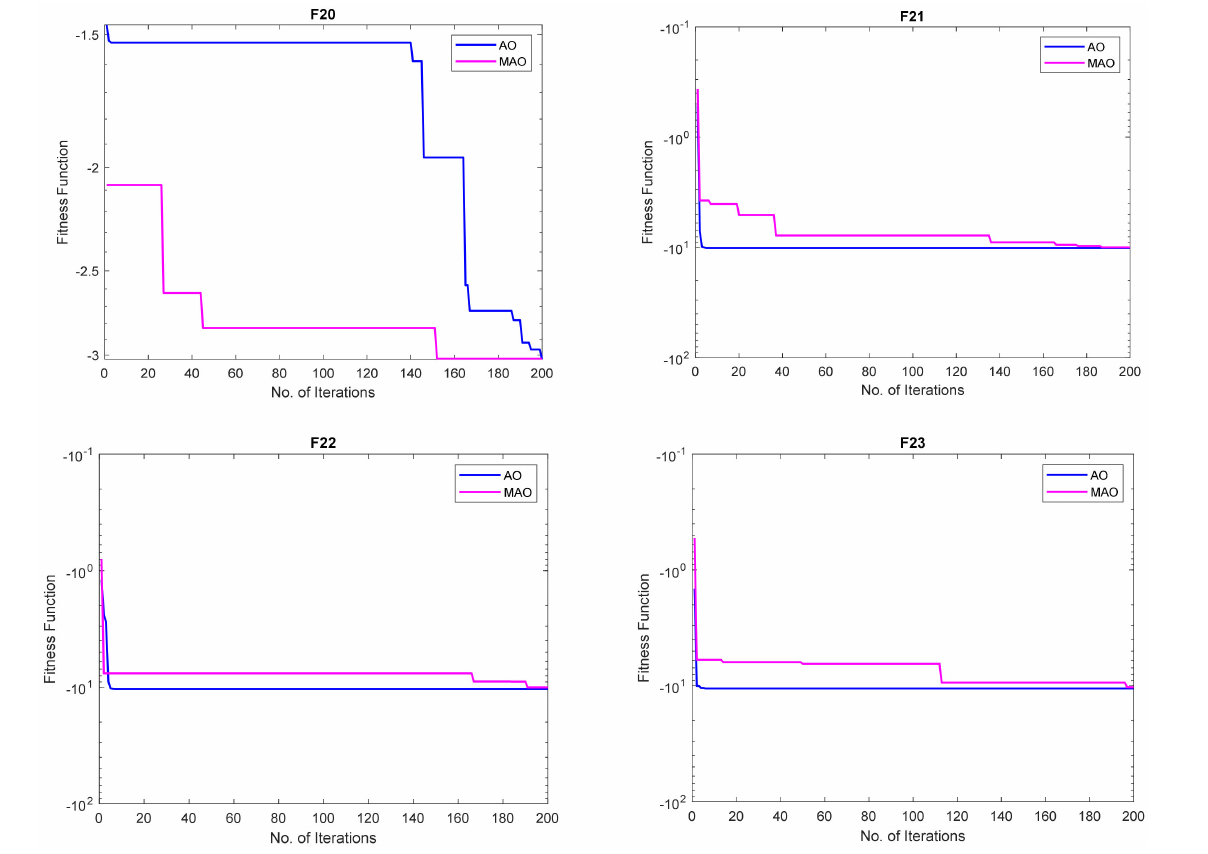
Figure 7. Convergence analysis of fixed-dimensional benchmark